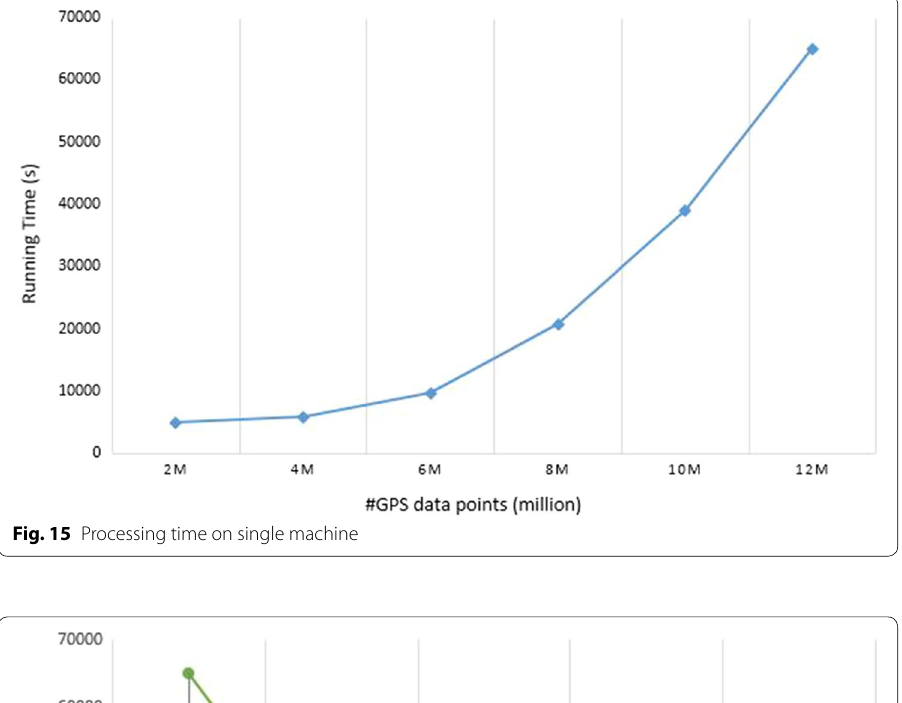
Fig. 15 Processing time on single machine